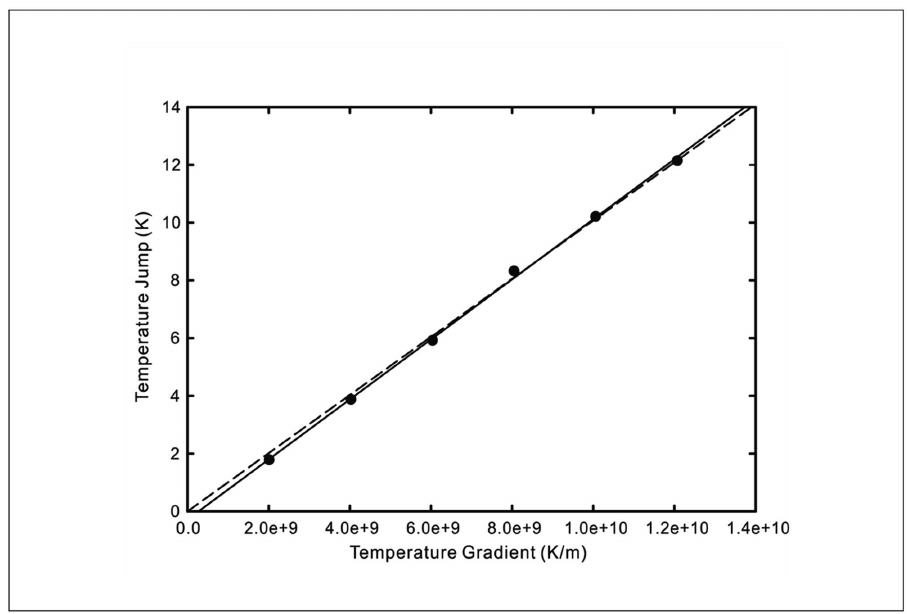
Fig 7. Temperature jump as a function of wall temperature gradient at a silica-SAM-water interface. Symbols: MD simulation results [17]. Solid line: New temperature jump model from Eq 8 with C 1 = 1.04 × 10 − 9 and C 2 = 9.682 × 10 − 4 for T w = 292 K . Dashed line: Existing temperature jump model from Eq 11 with C = 1.007 × 10 − 9 .